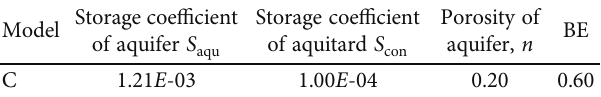
Table 2: Parameter preset for the fi tting of the barometric response with model C.